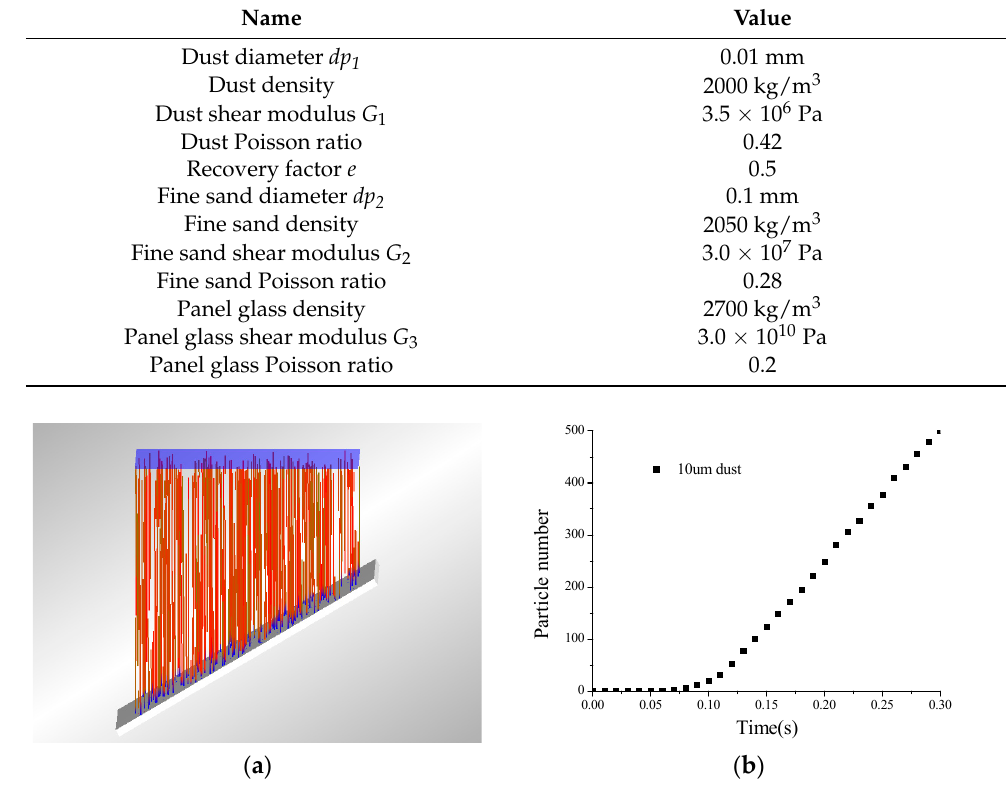
Figure 3. ( a ) The deposition of dust particles on the solar panel of 10 um clay particles under static wind with coherent energy parameter K = 0.5 × 10 5 Jm − 3 , and ( b ) the total number of particles deposited on the solar panel varying with time.